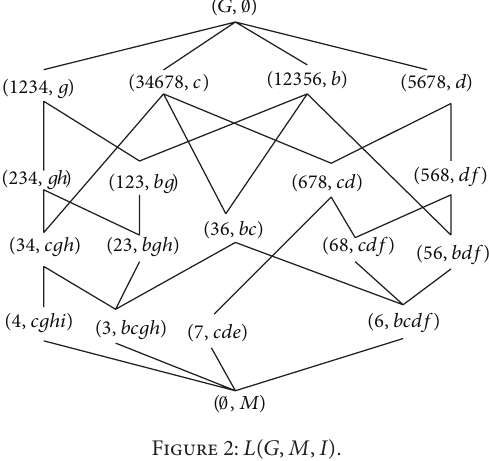
Figure 2: 𝐿(𝐺,𝑀, 𝐼)